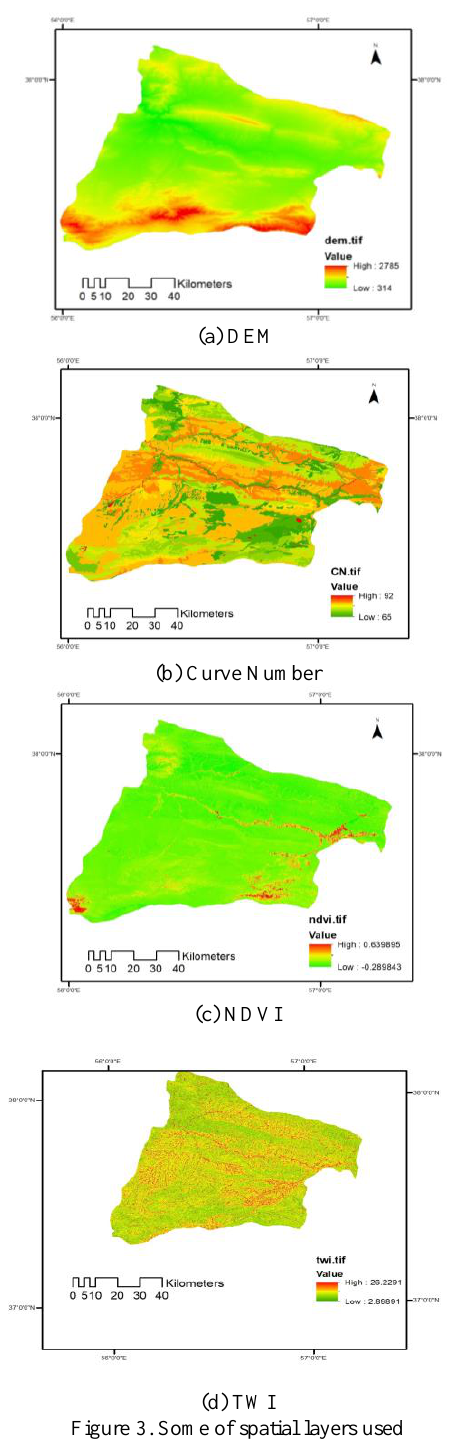
Figure 3. Some of spatial layers used